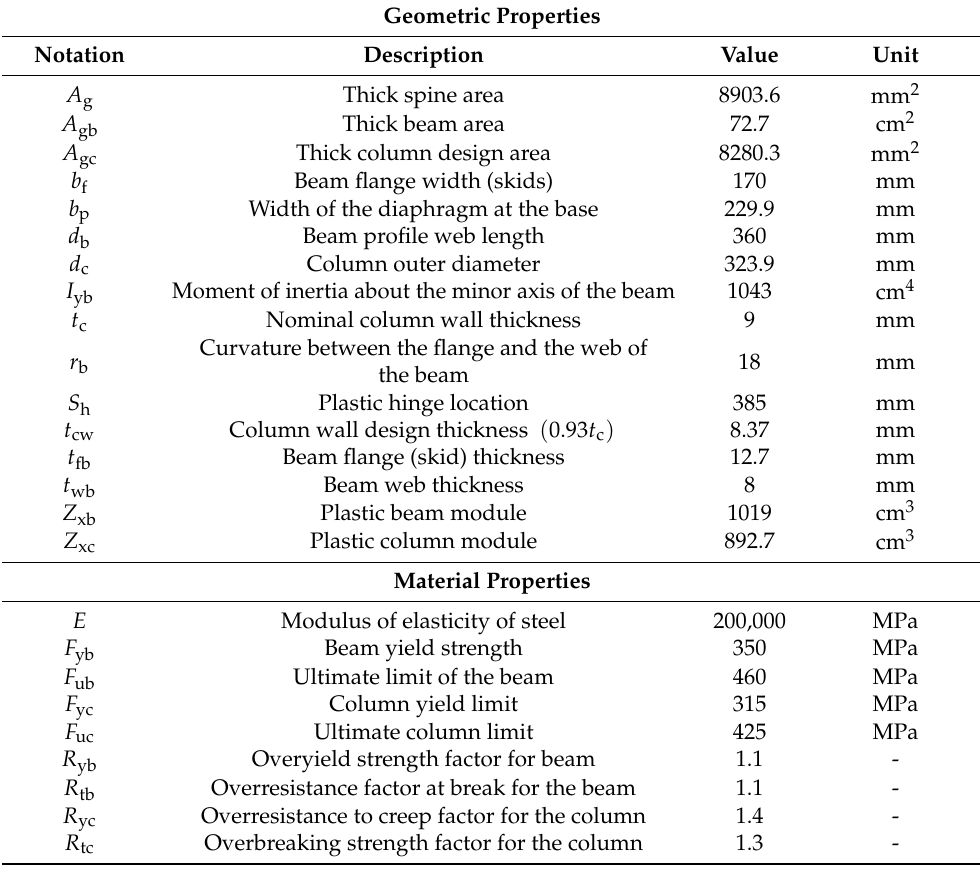
Table 1. Relevant values of the designed